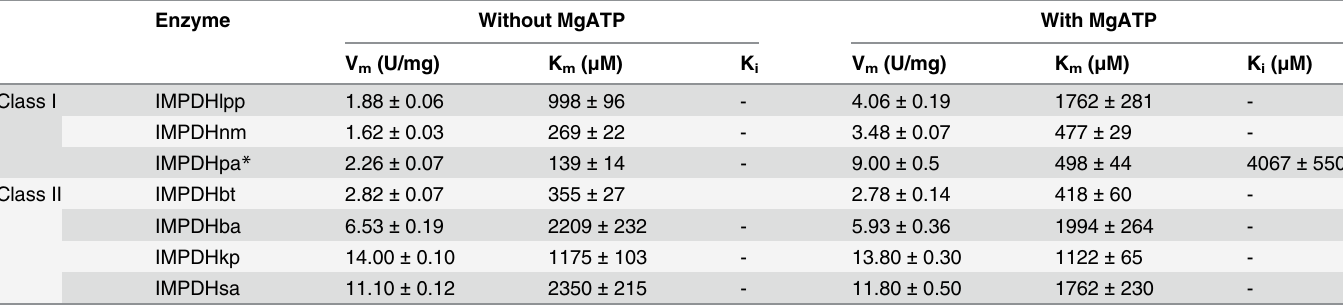
Table 5. Kinetic parameters of seven bacterial IMPDHs, with NAD as variable substrate. Reaction rates were determined at a constant saturating concentration of IMP (1 mM for IMPDHbt and IMPDHkp; 2 mM for IMPDHba, IMPDHsa and IMPDHlpp; 3 mM for IMPDHnm; 7 mM for IMPDHpa) and in the absence or presence of MgATP (2 mM for IMPDHnm; 3 mM for IMPDHpa; 5 mM for IMPDHlpp), and fi tted according to the Michaelis-Menten equation (see under Materials and Methods).